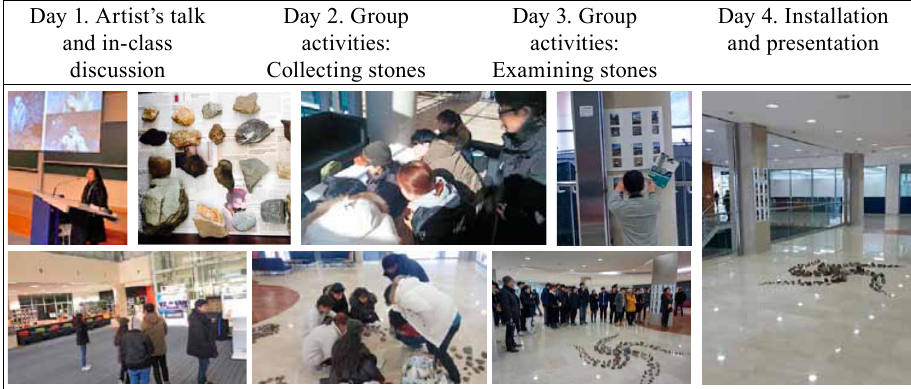
Table 7. Work process of group C (created by